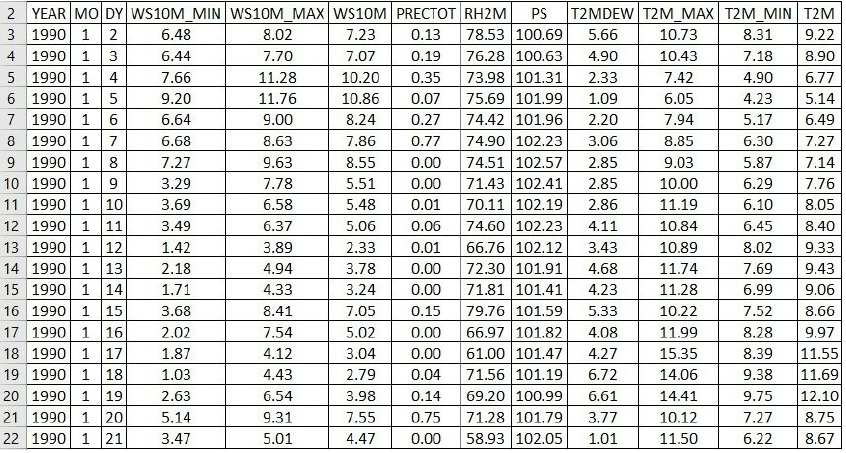
Figure 4. Data presented in Figure 3 after cleansing.